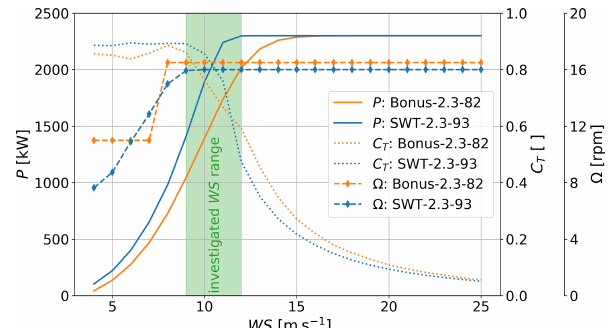
Figure 3. Power ( P , left axis), thrust curve ( C T , right axis) and rotor speed ( (cid:127) , rightmost axis) for the two turbine models of this study. The shaded green area indicates the investigated wind speed range in this study.